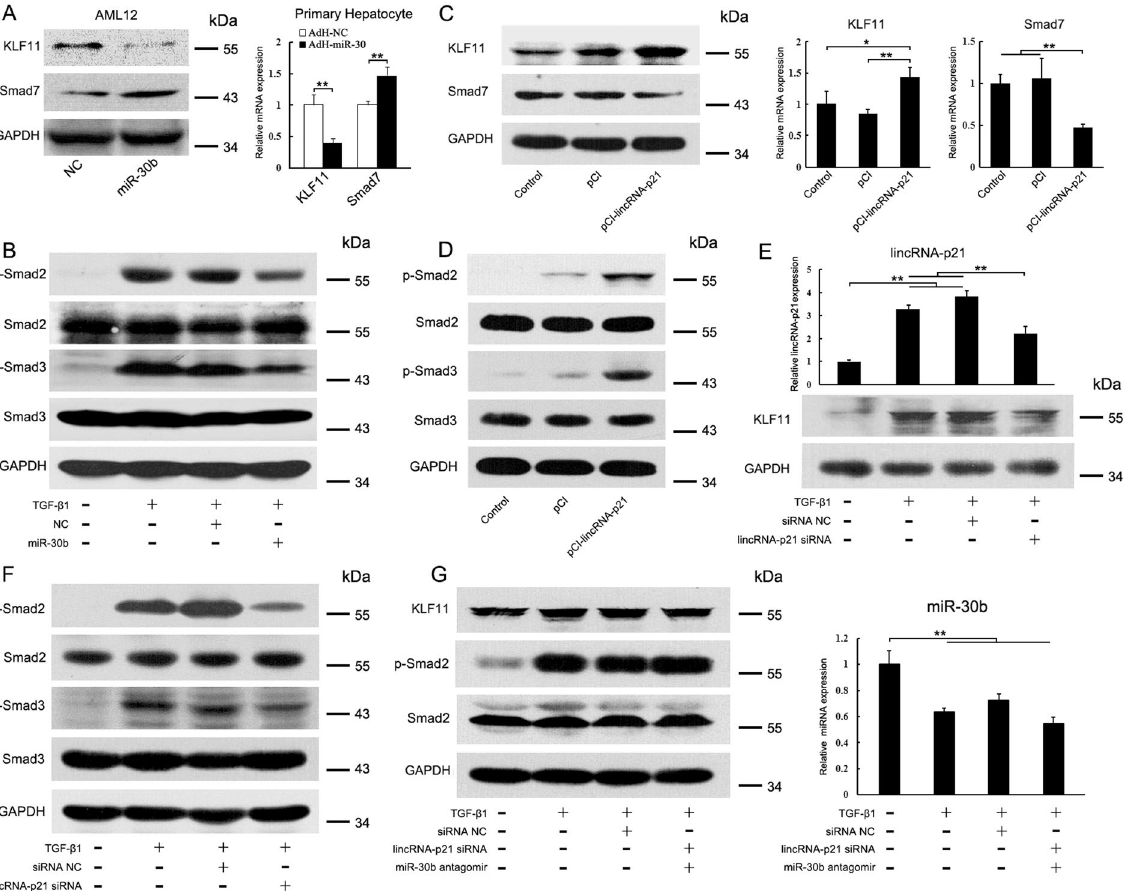
Figure 7. LincRNA-p21 enhances TGF- β /Smad signaling in hepatocyte by interacting with miR-30. ( A ) Effects of miR-30 on KLF11 and Smad7 expressions were determined by western blot and qRT-PCR. Left, AML12 were transfected with miR-30b mimics for 24 h. Right, primary hepatocytes were isolated from fibrotic liver injected with AdH-NC or AdH-miR-30. ( B ) miR-30 inhibits TGF- β /Smad signaling in hepatocyte. AML12 cells were transfected with miR-30b mimics, changed to serum-free DMEM for 24 h and then treated with TGF- β 1 for 2 h. p-Smad2, p-Smad3 and total Smad2, Smad3 were detected by western blot. ( C ) Ectopic expression of lincRNA-p21 increases KLF11 expression in hepatocyte. AML12 cells were transfected with pCI-lincRNA-p21 for 24 h. KLF11 and Smad7 expressions were determined by western blot and qRT-PCR. ( D ) Ectopic expression of lincRNA-p21 enhances TGF- β /Smad signaling in hepatocyte. AML12 cells were transfected with pCI- lincRNA-p21 for 24 h and then treated with TGF- β 1 for 2 h. ( E ) Knockdown of lincRNA-p21 reduces KLF11 expression in hepatocyte. AML12 cells were transfected with lincRNA-p21 siRNA for 24 h in the presence of TGF- β 1. Top, lincRNA-p21 was determined by qRT-PCR. Bottom, KLF11 was detected by western blot. ( F ) Knockdown of lincRNA-p21 inhibits TGF- β /Smad signaling. AML12 cells were transfected with lincRNA-p21 siRNA for 24 h and then treated with TGF- β 1 for 2 h. ( G ) Inhibition of miR-30 impairs the effects of lincRNA-p21 siRNA on TGF- β /Smad signaling. AML12 cells were co-transfected with lincRNA-p21 siRNA and miR-30b antagomir for 24 h and then treated with TGF- β 1 for 2 h. Left, p-Smad2 and total Smad2 were detected by western blot; Right, miR-30b levels were determined by qRT-PCR. The results are shown as fold change compared with control group. Data are the mean ± SEM of three independent experiments. * P < 0.05, ** P < 0.01. The original immunoblot images are shown in Supplementary Figure